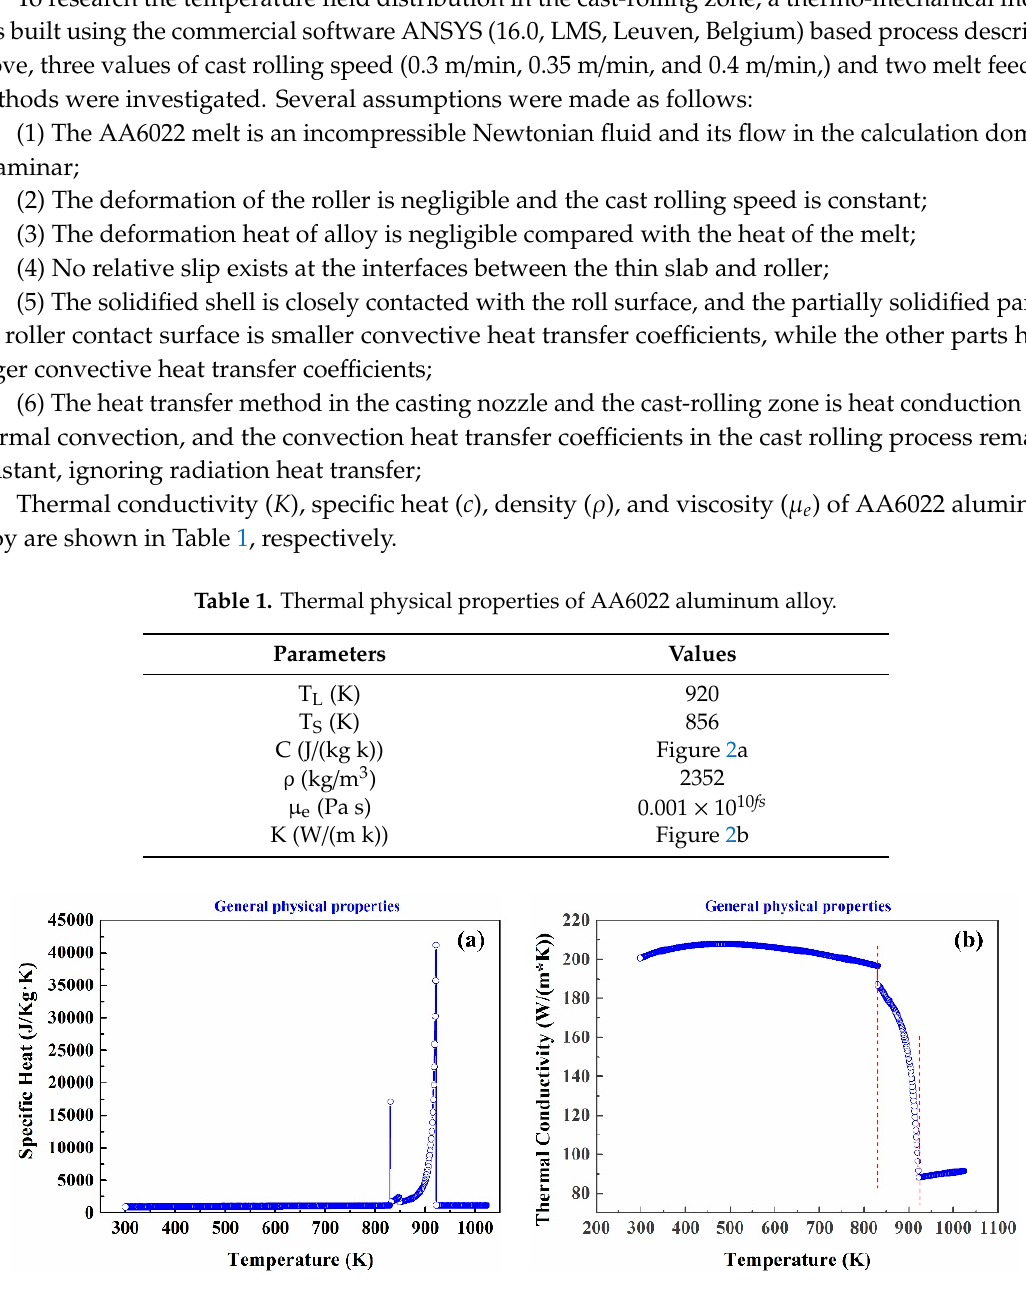
Figure 2. Thermal parameters of aluminum alloy AA6022 ( a ) specific heat ( b ) thermal conductivity.